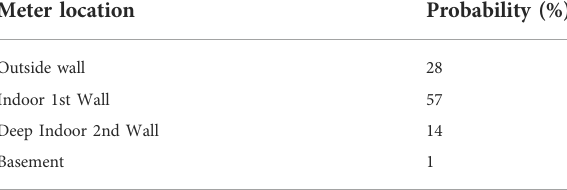
TABLE 3 Likely Meter Locations, as a percentage, within UK homes.